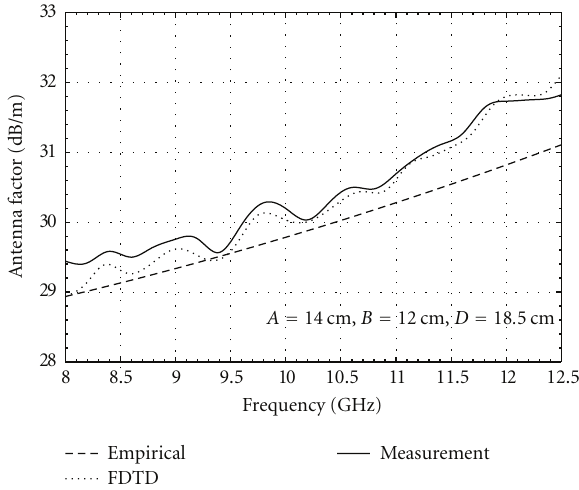
Figure 3: AF of pyramidal horn is computed using FDTD and empirical formula compared with the measurement.